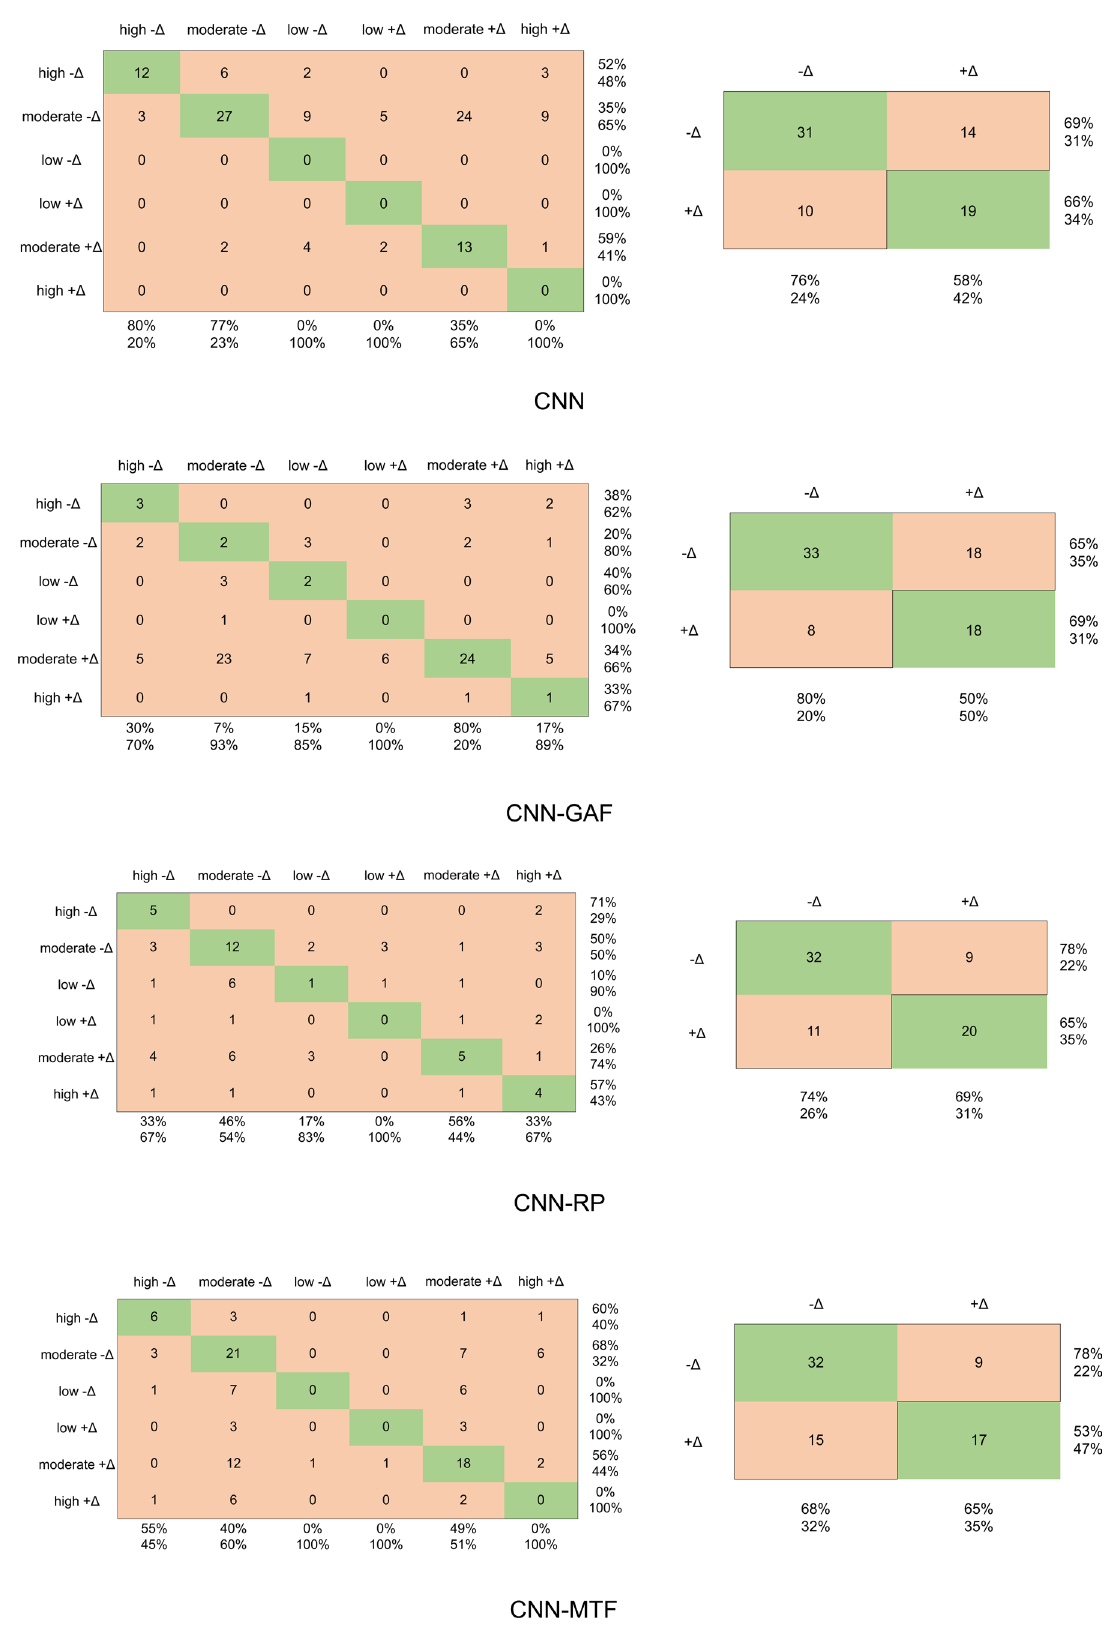
Fig. 13 Confusion matrix of scenario 1 (binary class) and scenario 2 (multi-class) for categorical-based streamflow